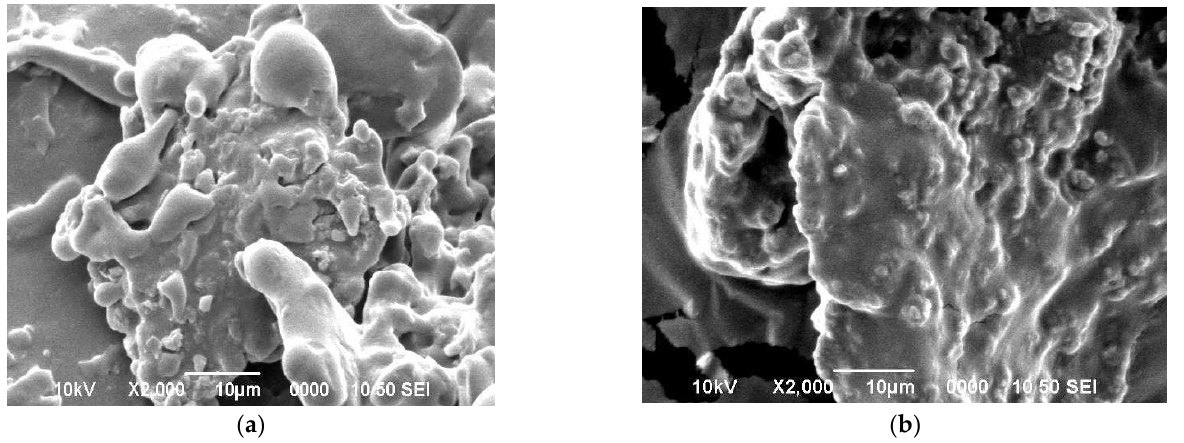
Figure 4. SEM of the EPS produced by the BU-4 isolate grown in glucose. ( a ) Undissolved EPS; ( b ) dissolved EPS.